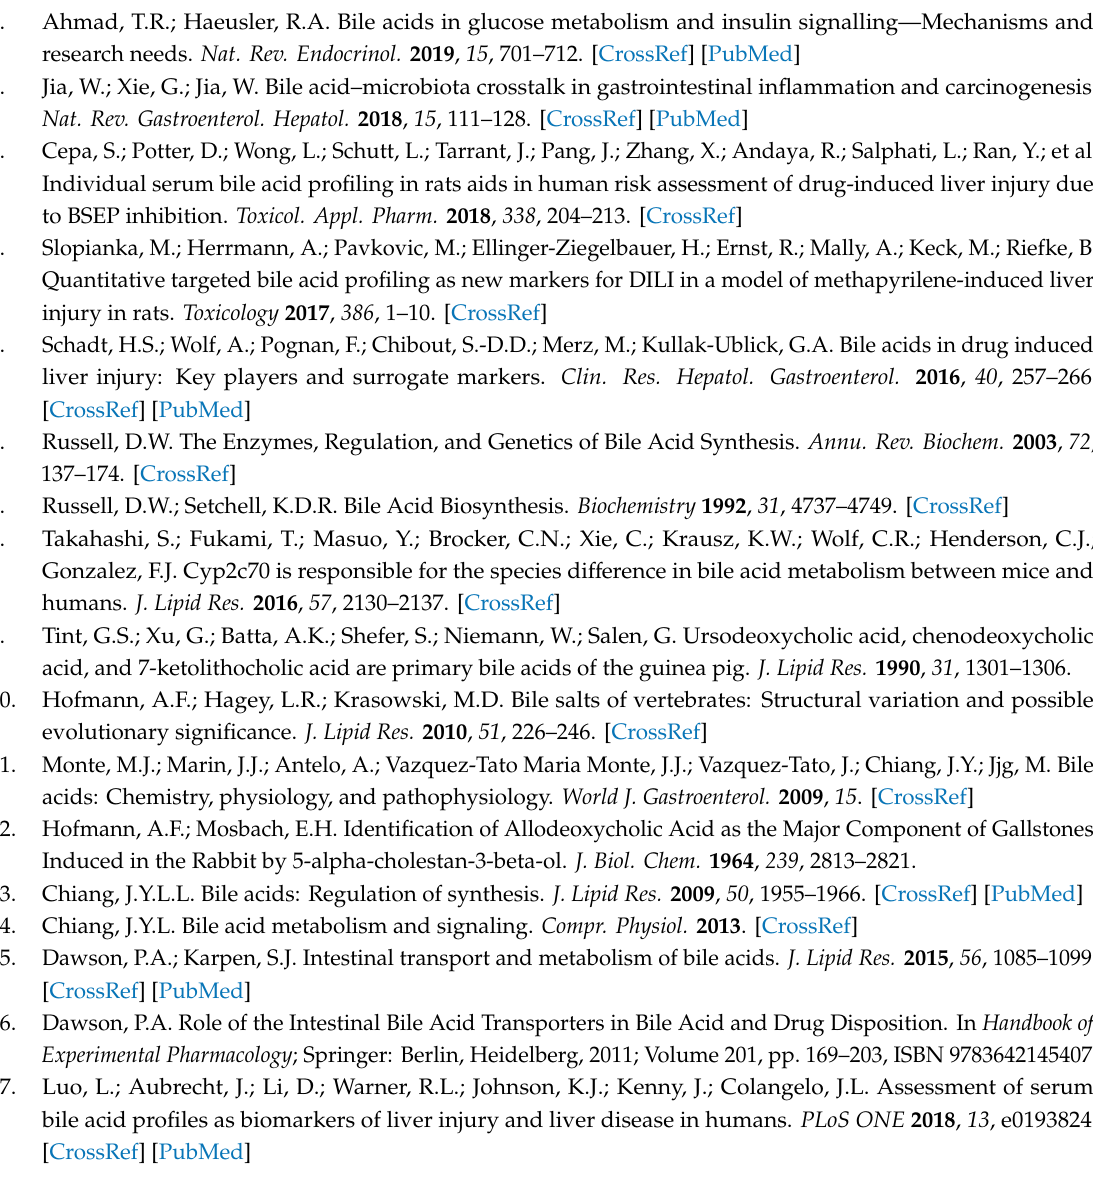
Figure S1: Lipid profile measured in simvastatin-treated and control mice, Table S1: Concentrations of individual bile acids quantified in serum, plasma and liver tissue from mice and in human plasma, Table S2: Concentrations of individual bile acids quantified in plasma and liver tissue in simvastatin-treated and control